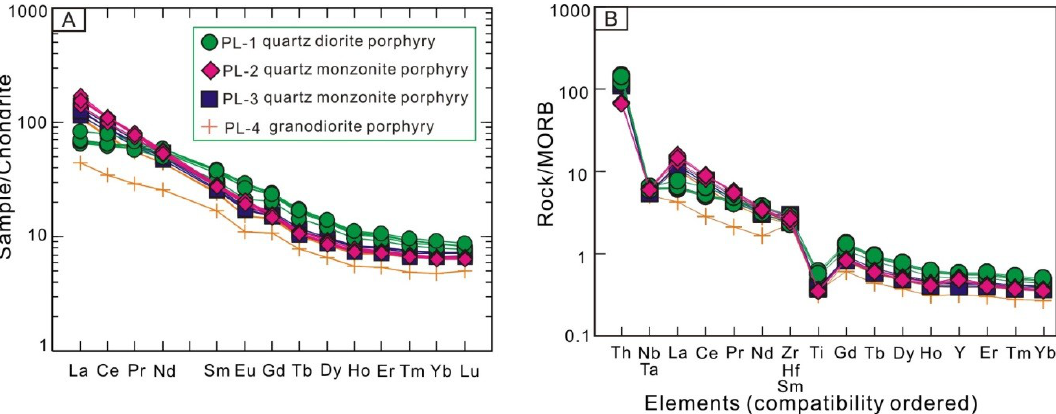
Figure 9. ( A ) Chondrite-normalized REE patterns and ( B ) MORB-normalized geochemical patterns for the Pulang porphyry intrusions (based on Pearce [55]). Chondrite and N-MORB values are from Boynton [56] and Sun and McDinough [57], respectively.